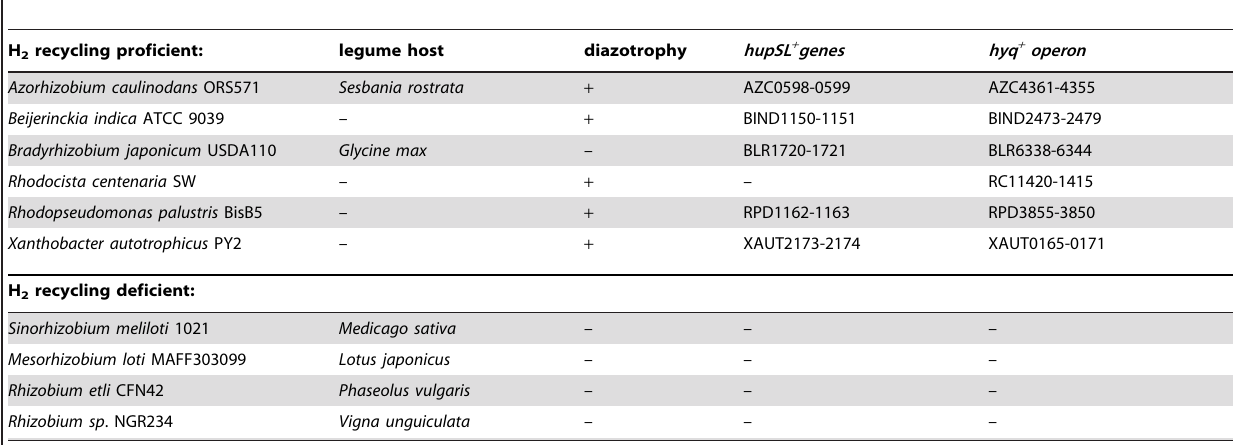
Table 2. N 2 -fixing microaerophilic a -proteobacteria carrying orthologous hup + /hyp + ( exo- hydrogenase) and hyq + ( endo - hydrogenase)